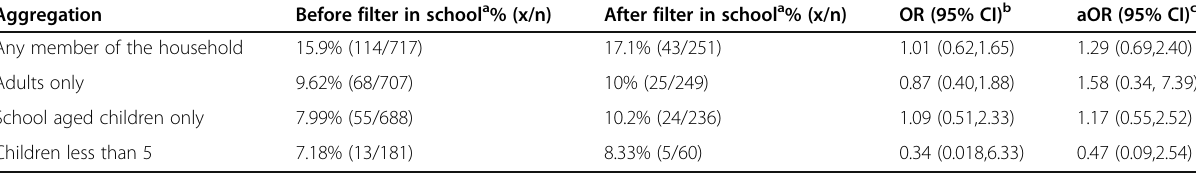
Table 4 Prevalence of self-reported diarrhea in household by school filter status